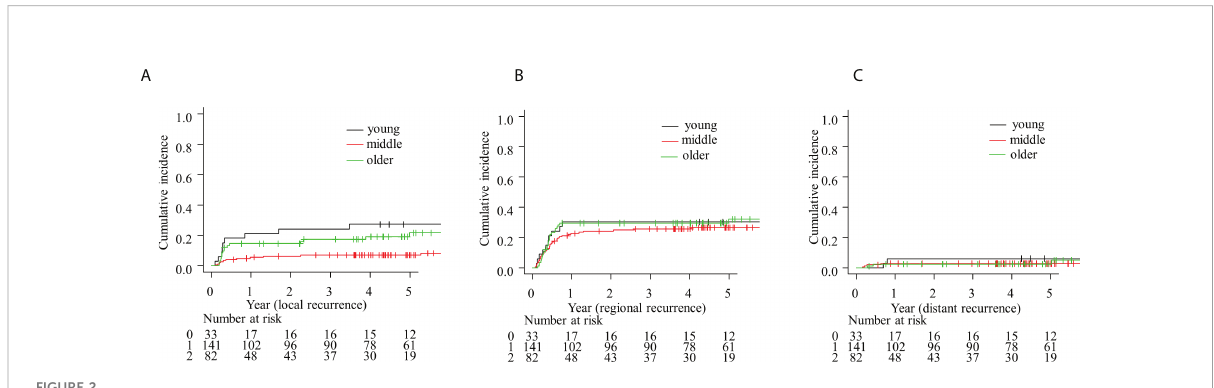
FIGURE 2 Competing risk model for (A) local, (B) regional, and (C) distant